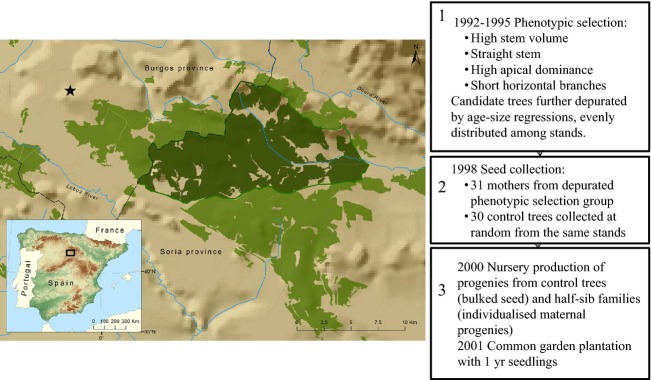
Location of the Pinus pinaster region of provenance Montaña de Soria-Burgos (light green), and the forest stand (dark green) where artificial selection for growth and timber yield was carried out. Boxes 1–3 describe the breeding programme from phenotypic selection to common garden establishment. Star denotes the location of the common garden.